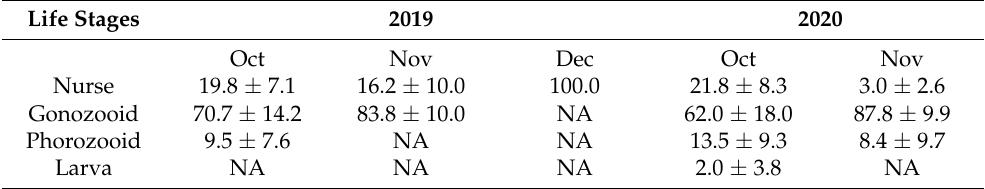
lateral view. Al., alimentray canal; Br, branchial septum; End, endostyle. ( b ) Mature gonad of a mature gonozooid. ( c ) Nurse stage. with sprouting trophozooids ( d ) with arrow indication. ( e ) Phorozooid stage with ventral peduncle (Vp.) details in ( f ), where sprouting gonozooids can be seen. Table 1. Dolioletta gegenbauri . Life stage compositions (%, mean ± SD) in the Jiaozhou Bay in each survey. n = 1–10, according to the numbers of stations with its